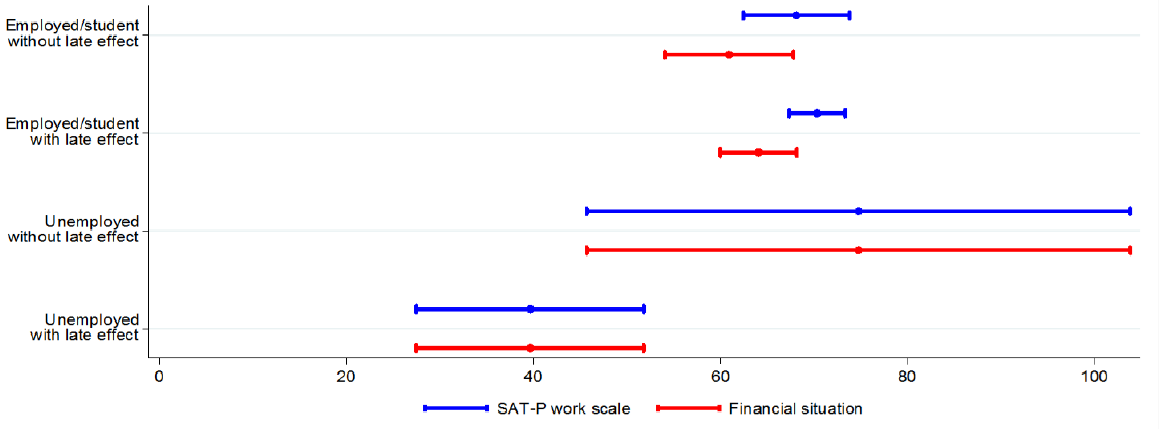
Figure 2. Work and financial situation satisfaction, according to occupational status and to the presence of late effect (mean).